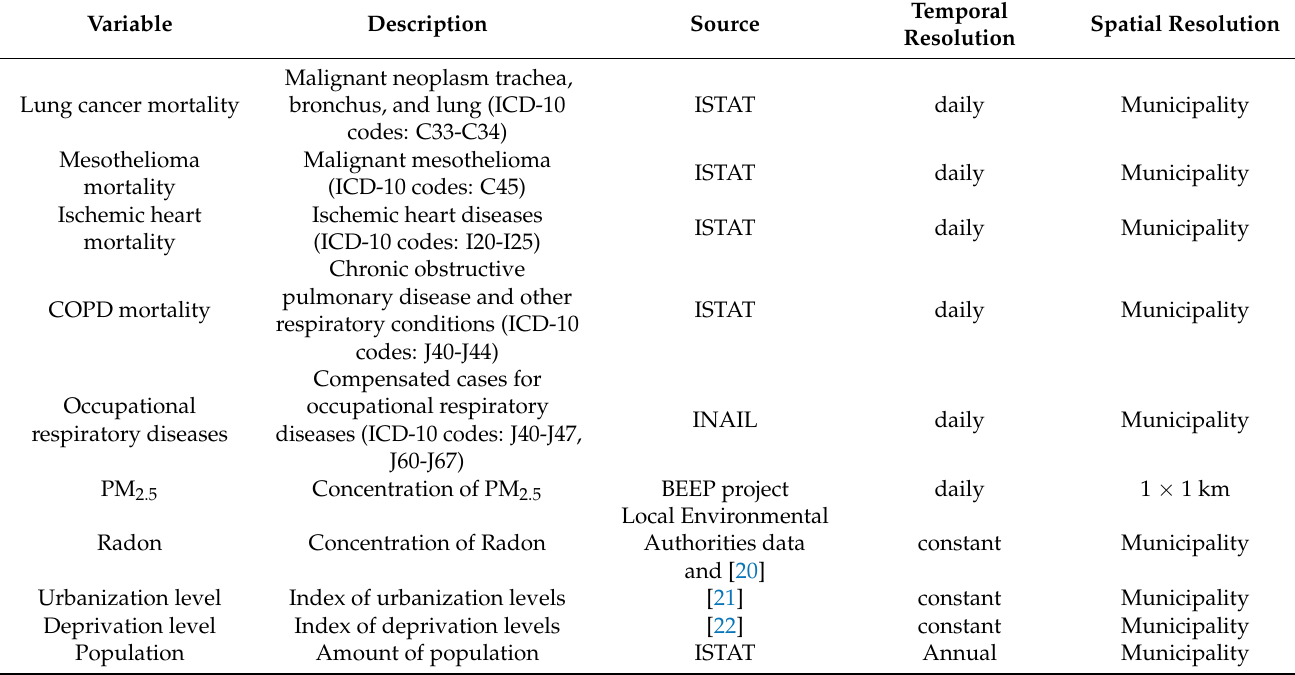
Table 1. List of variables used in the study (ISTAT: Italian National Institute of Statistics; INAIL: Italian Workers’ Com- pensation Authority; COPD: Chronic Obstructive Pulmonary Disease; BEEP: Big data in Environmental and occupational